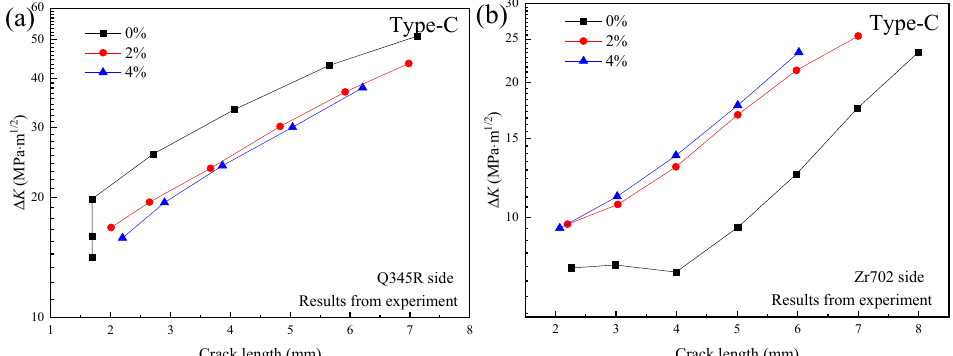
resulting in the decrease in Δ K at the crack tip, while on the other side, because the crack length is small, the stress concentration at the crack tip is increased, resulting in the in- crease in Δ K . Therefore, the great difference in crack growth length between the two sides leads to the significant difference in Δ K and the other two groups at the 0% pre-strain level. At the 2% and 4% pre-strain levels, the difference between the crack lengths on both Figure 9. Test results of cracks on both sides with different pre-strain levels: ( a ) Q345R side, ( b ) Zr702 side. sides is not obvious, which makes the Δ K results of each side crack close to each other.